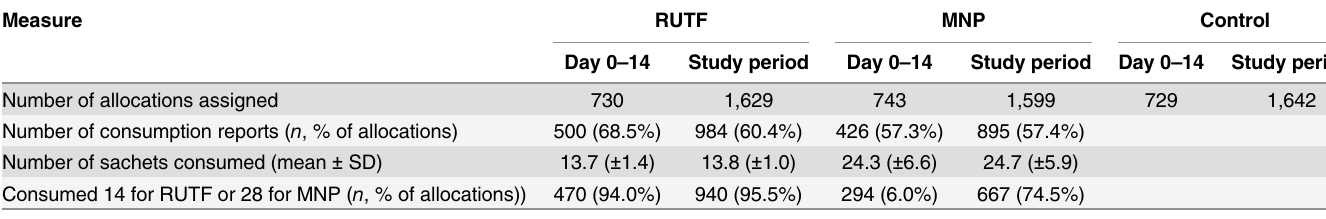
Table 8. Allocation of and compliance with supplements in intervention